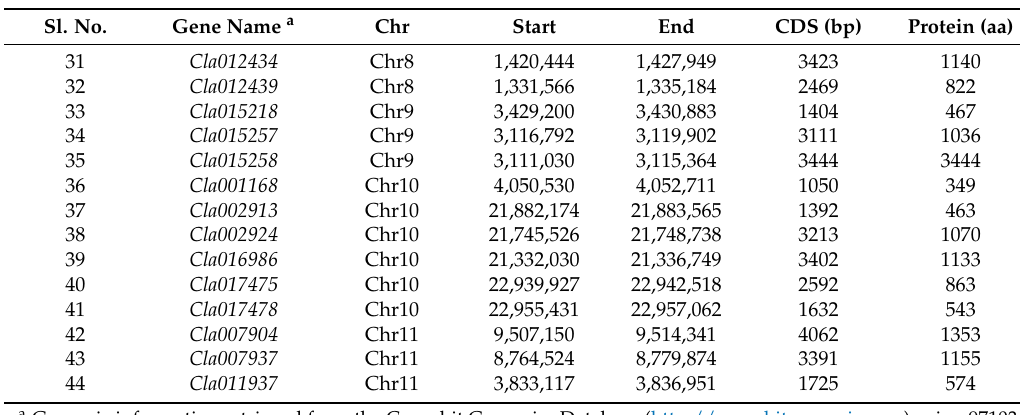
Table 2. Key domains in the 44 watermelon NBS proteins. Sl. no.